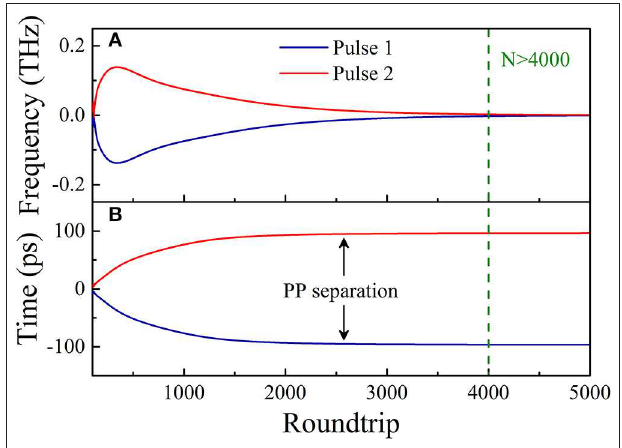
FIGURE 6 | (A) Instantaneous frequency at pulse peak F P and (B) pulse trajectory vs. roundtrip number N .